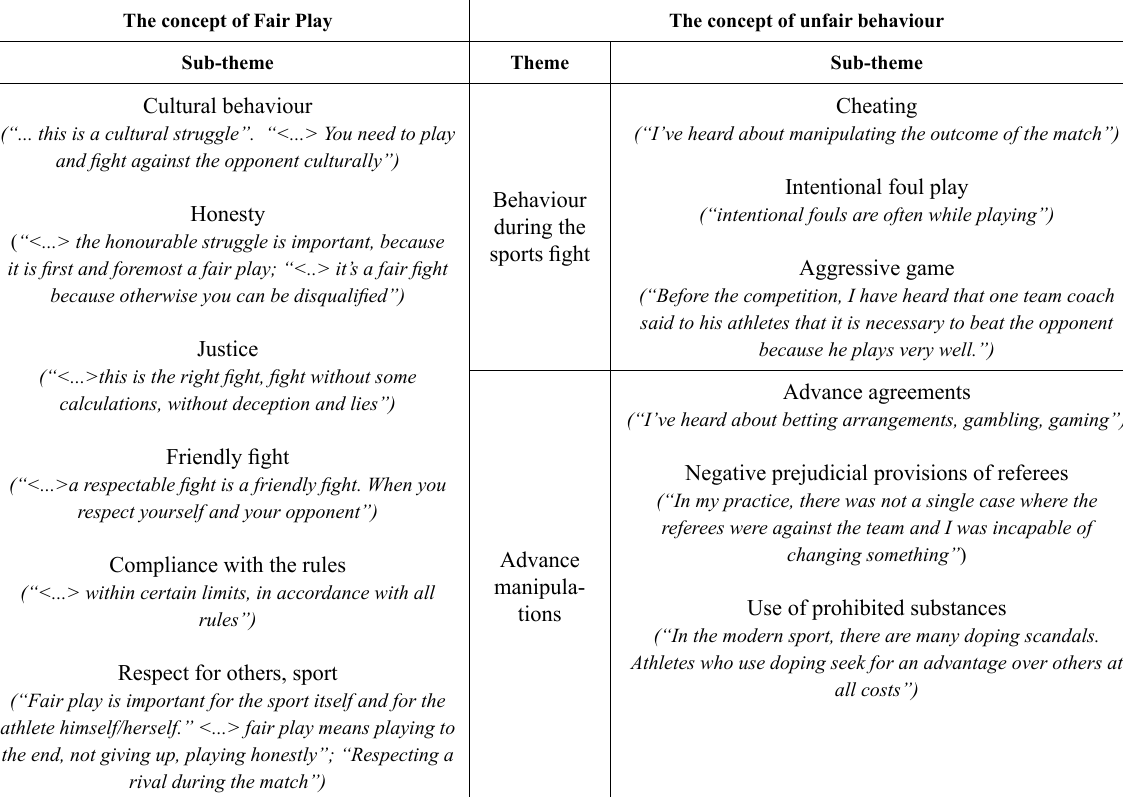
Table 3. Coaches’ perspectives about fair play and unfair